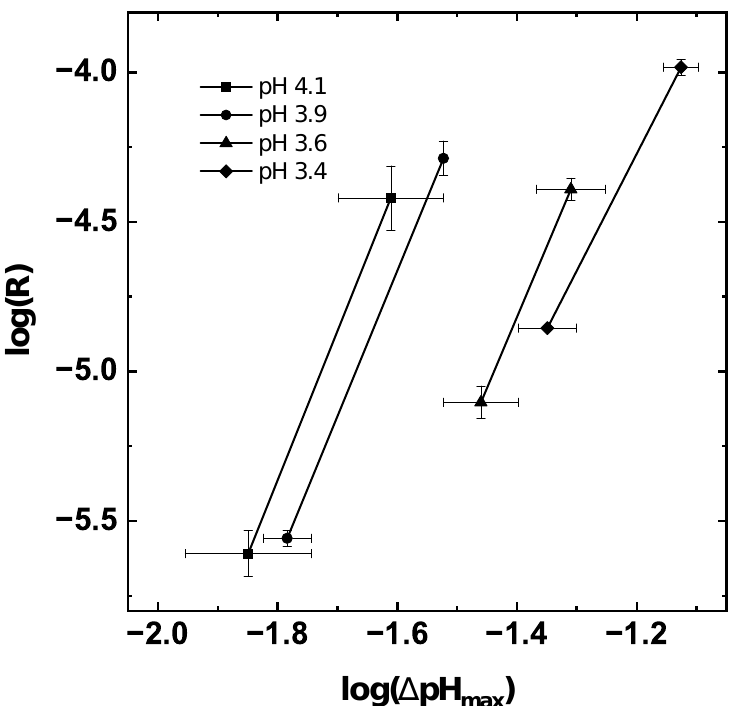
Figure 7. Logarithmic plot of the MSZW and the measured pH shift over the experiment duration ∆ pH R total = ∆ t for experiments with different saturation pH values. The points were calculated by the averaged MSZW and R total of two experiments. Straight line fits were used to estimate the kinetic nucleation